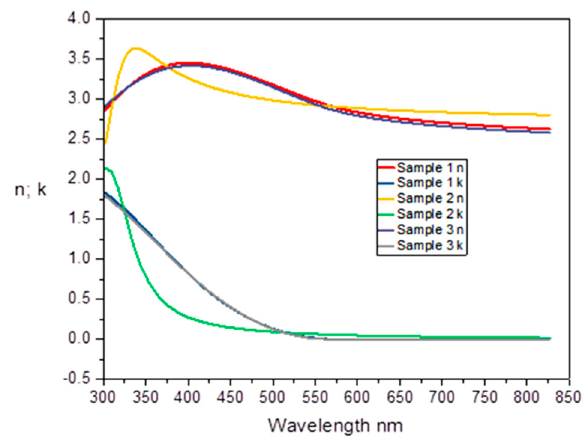
Figure 15. Graphs of n and k coe ffi cients for Samples 1, 2, and 3 of Cu 2 O:N thin films; λ is wavelength. The changes of n( λ ) (yellow curve) and k( λ ) (green curve) coe ffi cients observed in Figure 15